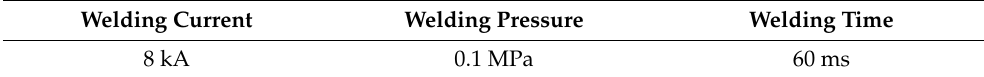
Table 2. Optimal welding parameters.